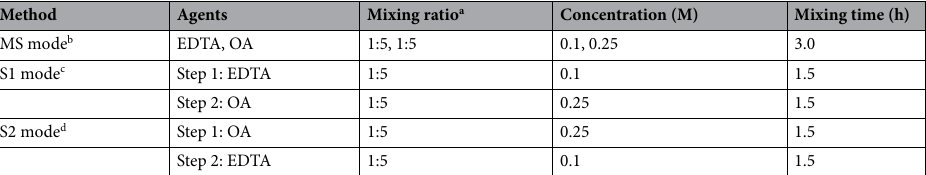
Table 2. Experimental conditions corresponding to the different modes of the advanced removal method for heavy metal removal from paper sludge ash. a Mixing ratio of paper sludge ash and solution. b Use of EDTA and OA simultaneously. c First step: EDTA; second step: OA. d First step: OA; second step: